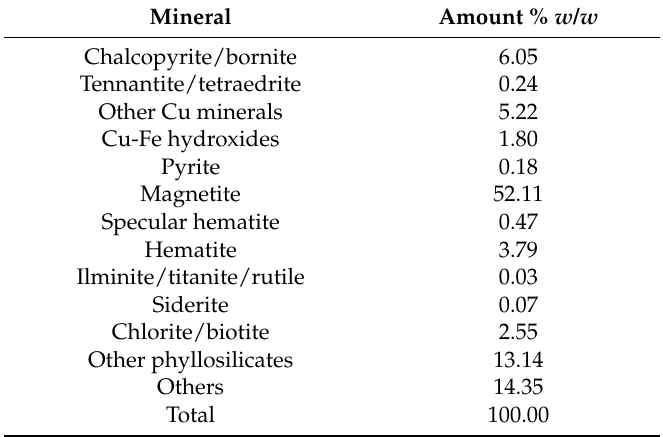
Table 3. The mineralogical composition of the slag as determined by